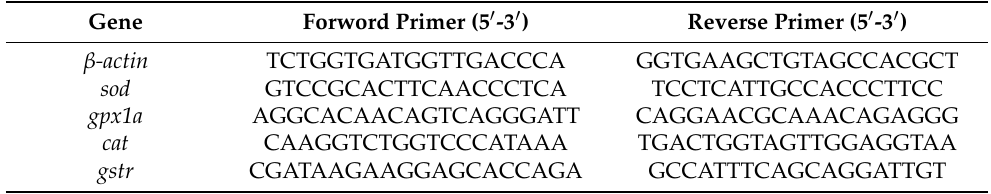
Table 1. Primers used in the real-time quantitative PCR analysis.